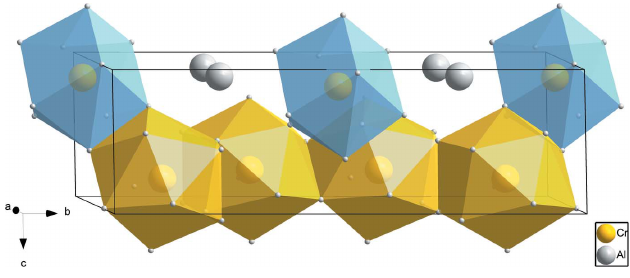
Figure 1 The crystal structure of ! -Al 4 Cr with coordination polyhedra displayed for Cr1 (gold) and Cr2 (pale